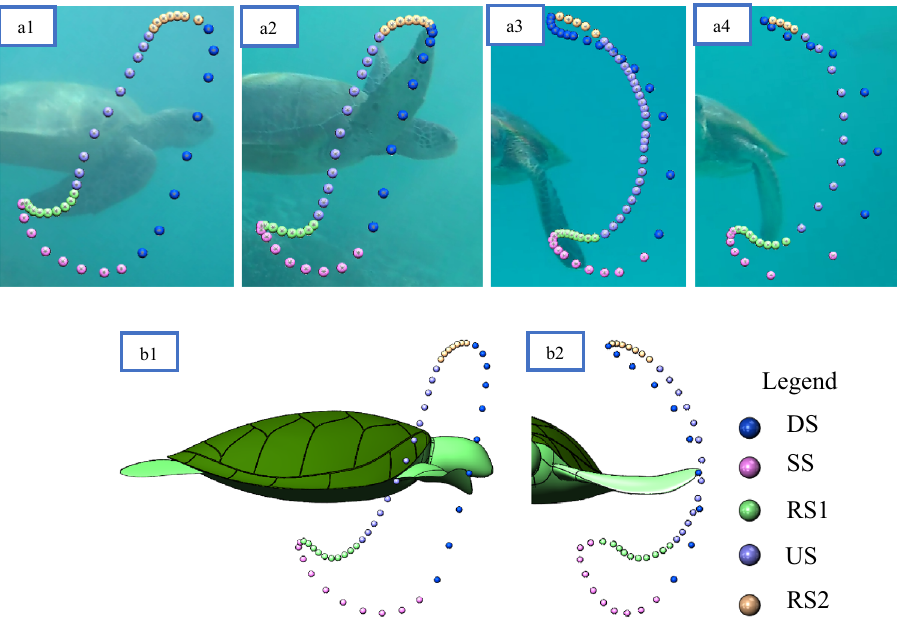
Figure 9. Comparison of various sea turtles filmed at different locations and times compared with the proposed three-dimensional model. ( a ) Observed Flipper paths from four different sea turtle specimens spheres within the figure representing the position of the flipper tip at 0.1-s increments. ( b ) The proposed 3D model flipper path with spheres within the figure represents the flipper tip’s position at 0.084-s